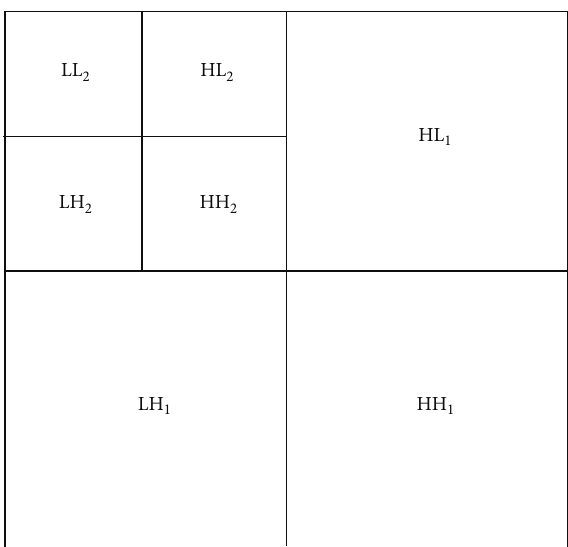
Figure 5: Two-level image decomposed using DWT for one color channel.